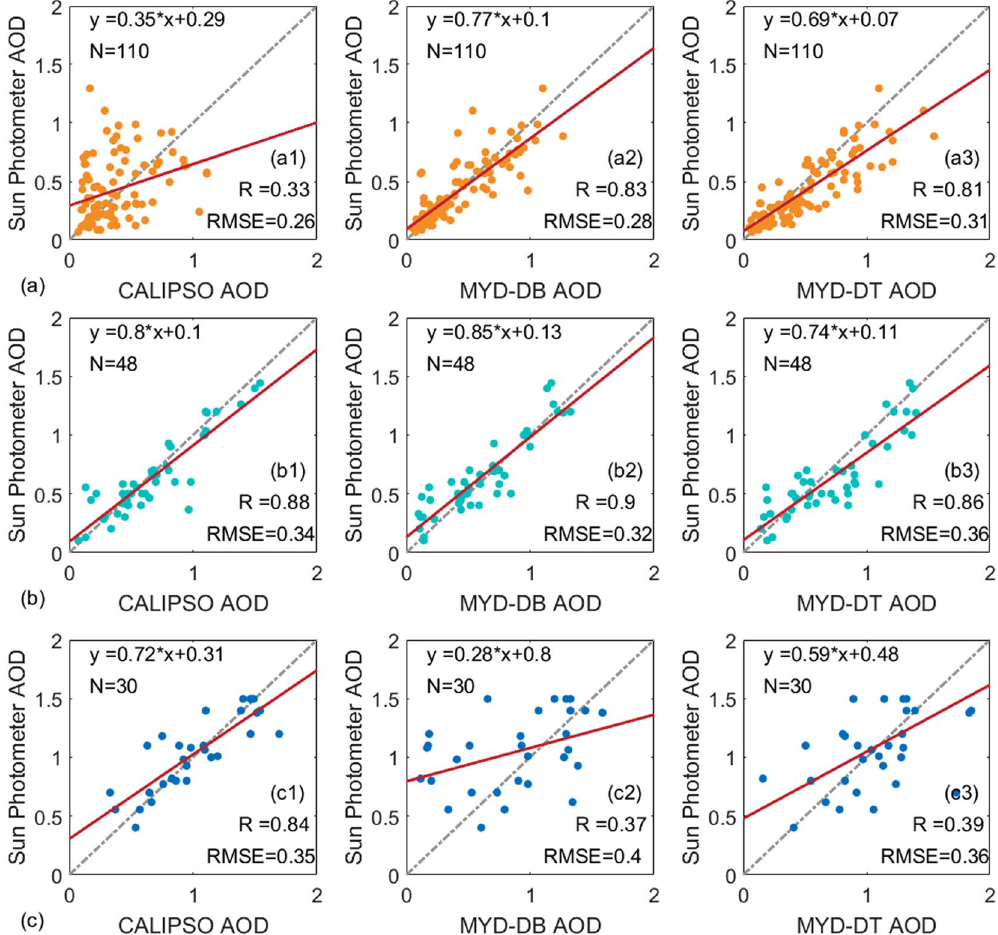
Figure 2. Scatter plots of AODs derived from CALIPSO, MODIS, and sun photometer under different air quality conditions. ( a ) Orange, ( b ) green, and ( c ) blue points represent sample points under clean weather, moderate air pollution, and heavy air pollution, respectively. Red and grey lines represent the linear regression curve and 1:1 reference curve,